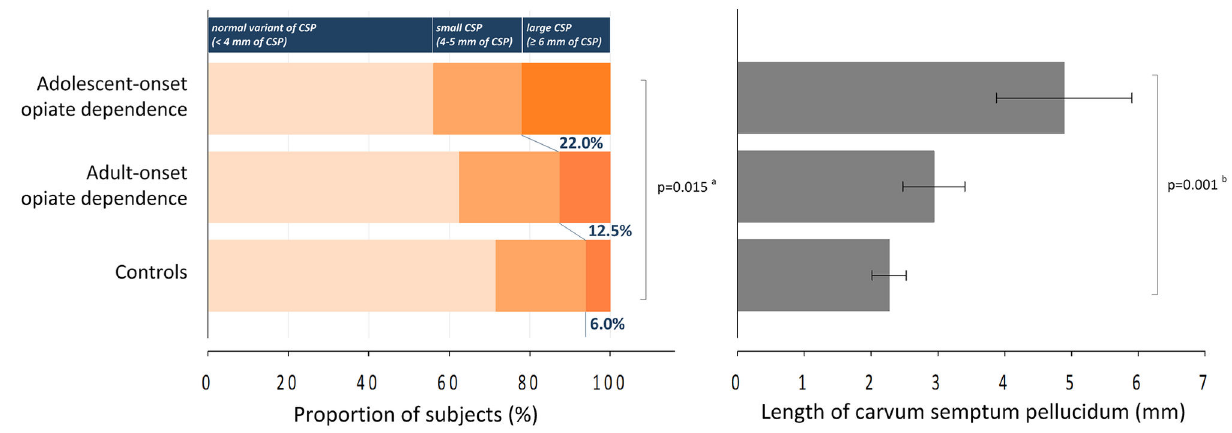
Figure 2. Prevalence of CSP enlargement and mean values of CSP length among adolescent-onset and adult-onset opiate- dependent subjects and healthy subjects. a p value was calculated by using the ordinal logistic regression model for the comparison of the prevalence of an enlarged CSP (≥ 6 mm in CSP length) among adolescent-onset and adult-onset opiate- dependent subjects and healthy subjects, including age and sex composition as relevant covariates. b p value was calculated by using the analyses of covariance for linear trend for the comparison of the continuous CSP length between groups including age and sex as covariates. Error bars in the right graph indicate standard errors. Abbreviations: CSP, cavum septum pellucidum. doi: with CSP enlargement (adjusted OR=3.20, 95% CI=1.13-9.05, p=0.028).